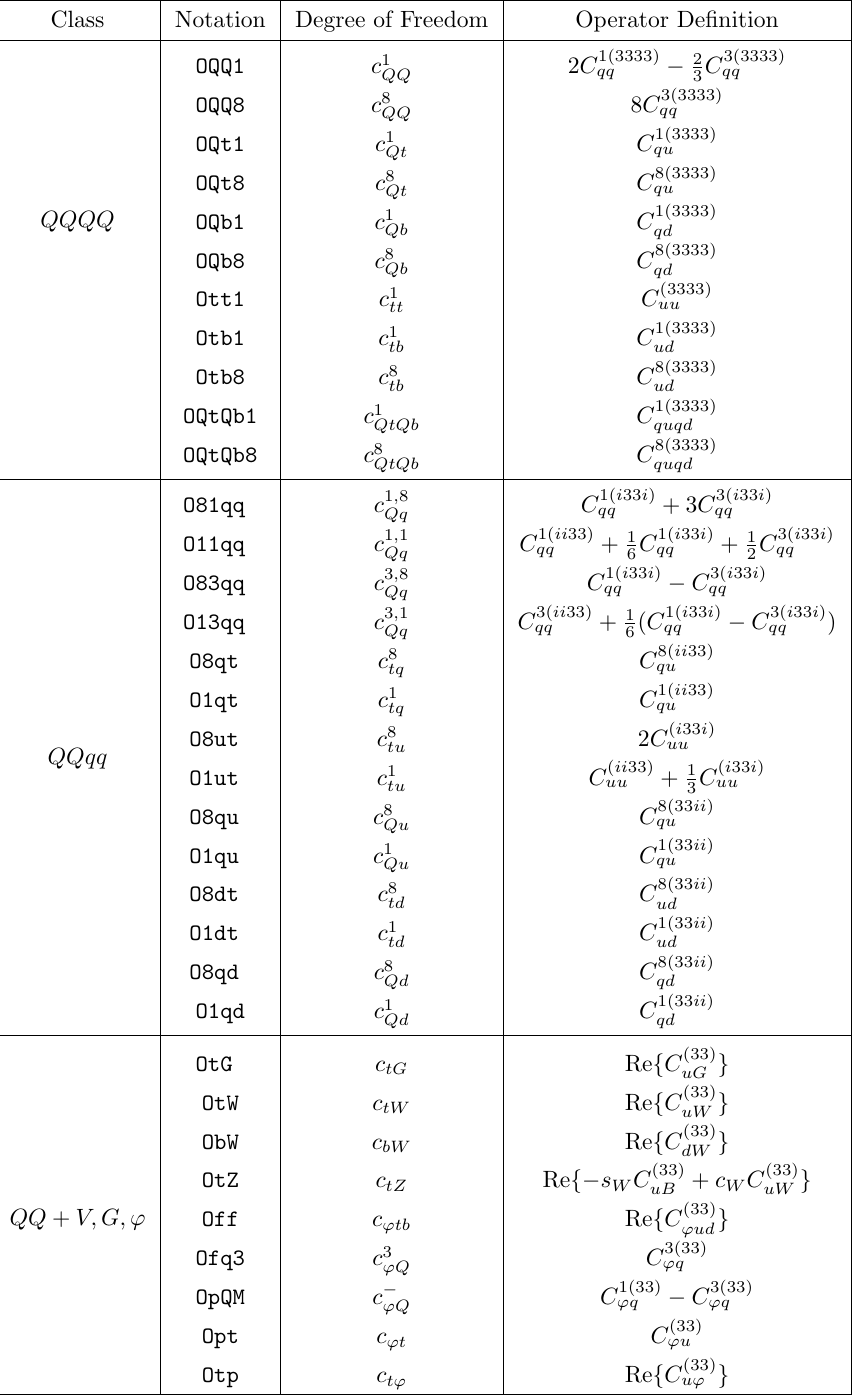
Table 1 . The notation that we will use to denote the results of the (cid:12)ts presented in this work. In each case, we indicate the internal notation for the degree of freedom and the corresponding de(cid:12)nition in terms of the operators in the Warsaw basis. The degrees of freedom are divided into three classes: four-heavy-quark operators ( QQQQ ), two-heavy-two-light-quark operators ( QQqq ), and operators that couple two heavy quarks to gauge and Higgs bosonic (cid:12)elds ( QQ + V; G; ’